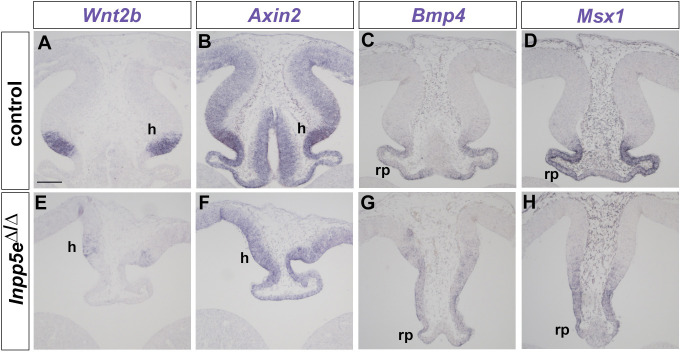
Wnt/β-catenin and Bmp signaling in the dorsomedial telencephalon of E12.5 Inpp5eΔ/Δ embryos.(A, B, E, F) Reduced Wnt/β-catenin signaling in Inpp5eΔ/Δ embryos. (A, E) Wnt2b expression is confined to the cortical hem (h) while there are only few scattered Wnt2b expressing cells in the mutant. (B, F) Graded expression of the Wnt target gene Axin2 in the dorsal midline is reduced in mutant embryos. (C, D, G, H) Roof plate (rp) expression of Bmp4 and its target gene Msx1 are reduced in Inpp5eΔ/Δ embryos. Scale bar: 100 μm.